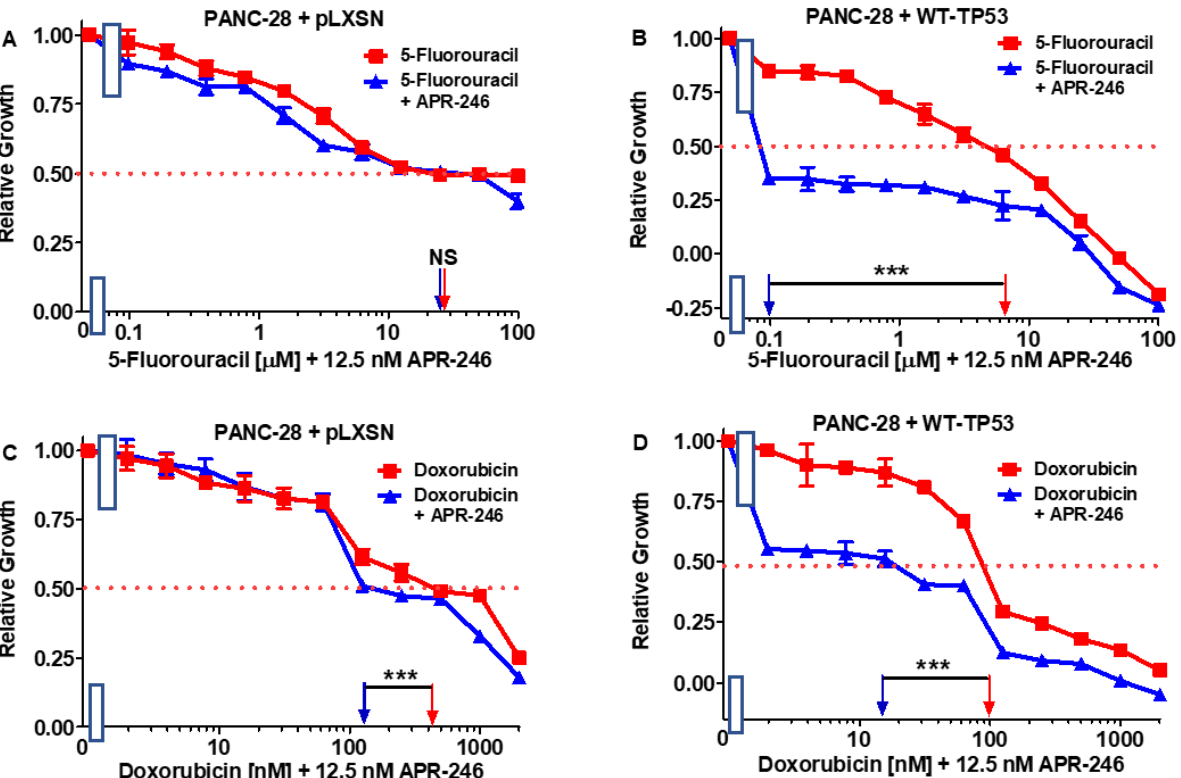
Figure 7. Effects of combining a constant concentration of 12.5 nM APR-246 on the IC 50 value of 5FU and doxorubicin in PANC-28 + pLXSN and PANC-28 + WT-TP53 cells. Panel ( A ) PANC-28 + pLXSN cells treated with different concentrations of 5FU (red squares) and PANC-28 + pLXSN cells treated with different concentrations of 5FU and a low dose of 12.5 nM APR-246 (blue triangles). Panel ( B ) PANC-28 + WT-TP53 cells treated with different concentrations of 5FU (red squares) and PANC-28 + WT-TP53 cells treated with different concentrations of 5FU and a low dose of 12.5 nM APR-246 (blue triangles). Panel ( C ) PANC-28 + pLXSN cells treated with different concentrations of doxorubicin (red squares) and PANC-28 + pLXSN cells treated with different concentrations of doxorubicin and a low dose of 12.5 nM APR-246 (blue triangles). Panel ( D ) PANC-28 + WT-TP53 cells treated with different concentrations of doxorubicin (red squares) and PANC-28 + WT-TP53 cells treated with different concentrations of doxorubicin and a low dose of 12.5 nM APR-246 (blue triangles). *** = p < 0.0001, NS = not statistically significant.